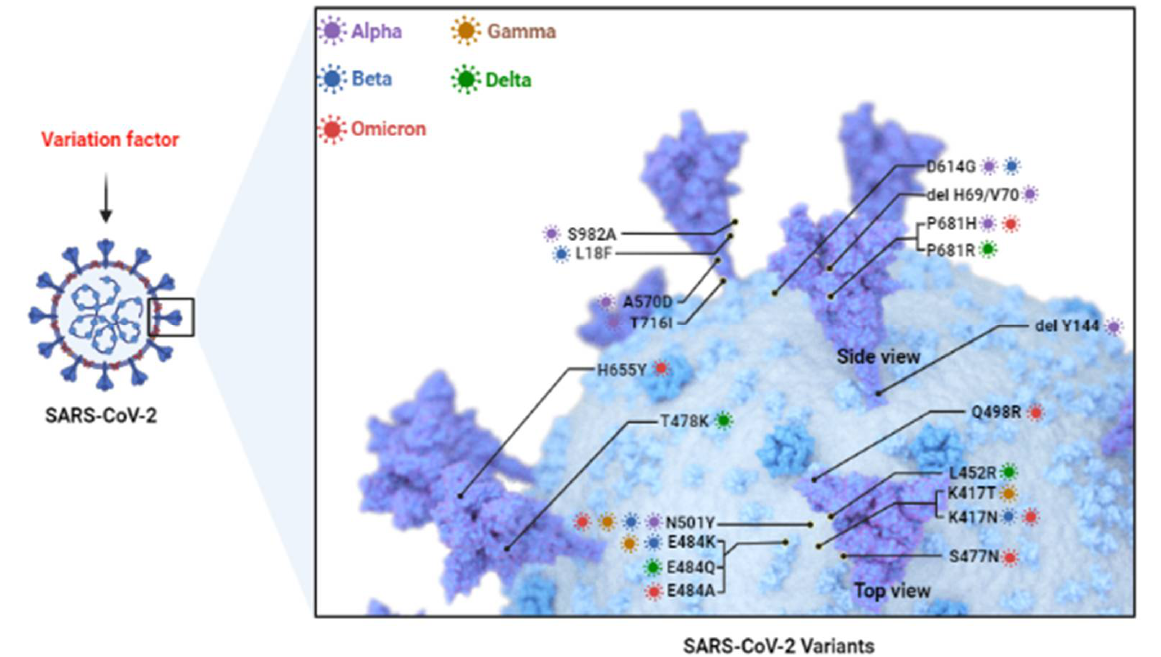
Figure 1. SARS-CoV-2 Variants. Currently common variants include Alpha, Beta, Gamma, Delta, and Omicron. They mainly consist of mutations in S protein such as D164G, N501Y, E484K, K417N, etc. ( Adapted from “The SARS-CoV-2 Variants of Concern”, by BioRender.com (2022). Retrieved from https://app.biorender.com/biorender-templates (accessed on 28 July 2022).